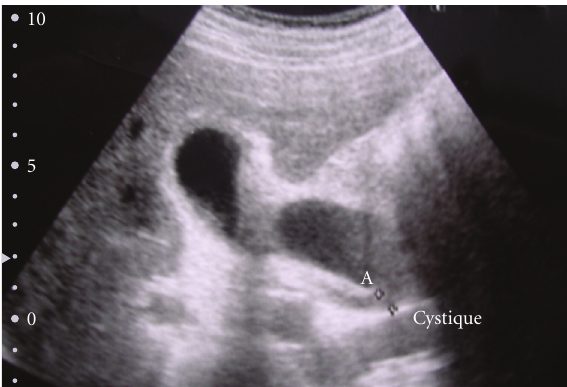
Figure 1: US findings showing a “bilobar” gallbladder.